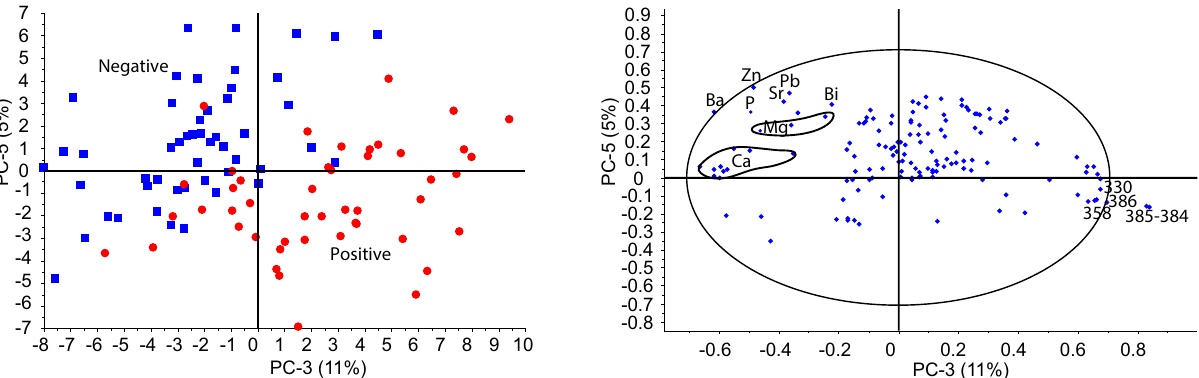
Figure 5. PCA of fused data of all 97 samples. Only PC 3 and 5 are shown here as they distinguish samples from positive and negative donors on the score plot. The loading plot shows some of the elements in all